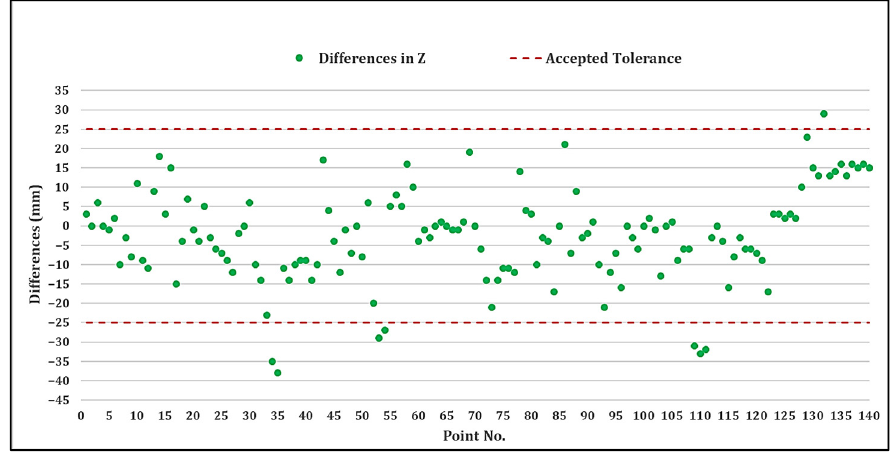
Figure 13. Differences between the extracted points by the proposed method and total station coordinates on the Z axis of the second test.